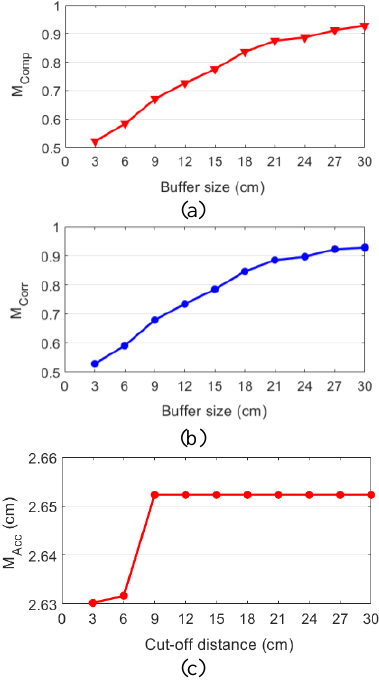
Fig. 9. Quality evaluation of the 3D model of the interior space of the TUB1 building: (a) Completeness; (b) Correctness; (c)